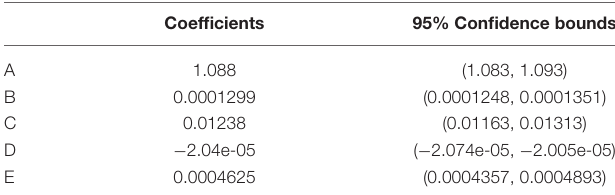
TABLE 1 | Coefficients with 95% confidence bounds for Equation 3, determined from the data in Figure 3 . Coefficients